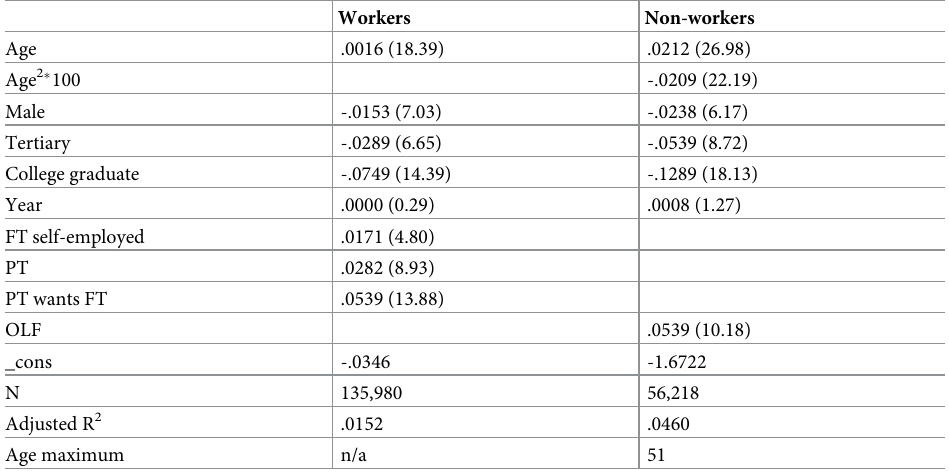
Table 5. OLS pain in the OECD, 2009–2020 age 15–65.